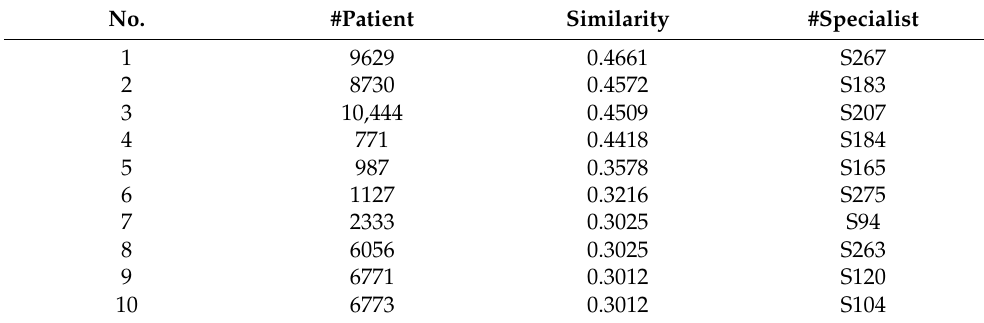
Table 4. Similarity of the target patient.